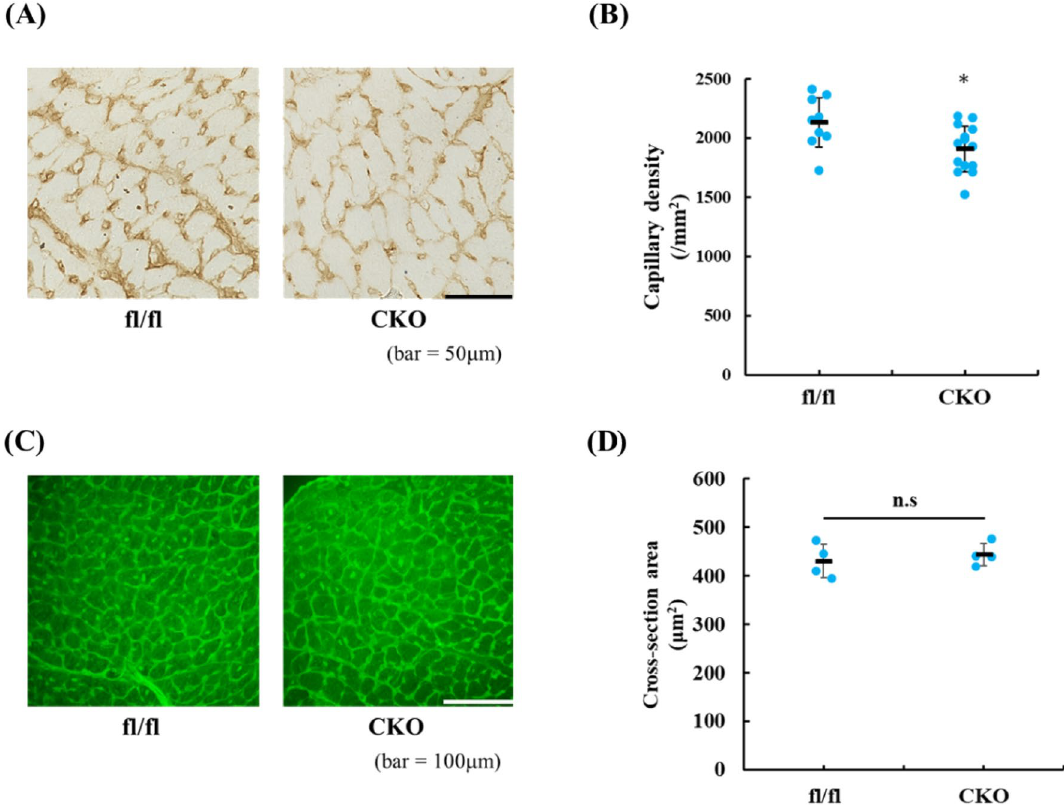
Figure 4. Capillary density was reduced in the post-infarct myocardium of Runx2 CKO mice. ( A ) Heart sections were prepared from Runx2 fl/fl and Runx2 CKO mice 14 days after MI. The sections were stained with anti-CD31 antibody. Representative images are shown. ( B ) Capillary density was quantitatively estimated. Data are shown as mean ± SD (n = 11 for Runx2 fl/fl mice, n = 14 for Runx2 CKO mice), * P < 0.05 vs Runx2 fl/fl by Student’s t -test. ( C ) Heart sections were prepared from Runx2 fl/fl and Runx2 CKO mice 14 days after MI. The sections were stained with wheat germ lectin conjugated with fluorescein isothiocyanate. Representative images are shown. ( D ) Cross-sectional area was quantitatively estimated. Data were shown as mean ± SD (n = 4 for Runx2 fl/fl mice, Runx2 CKO